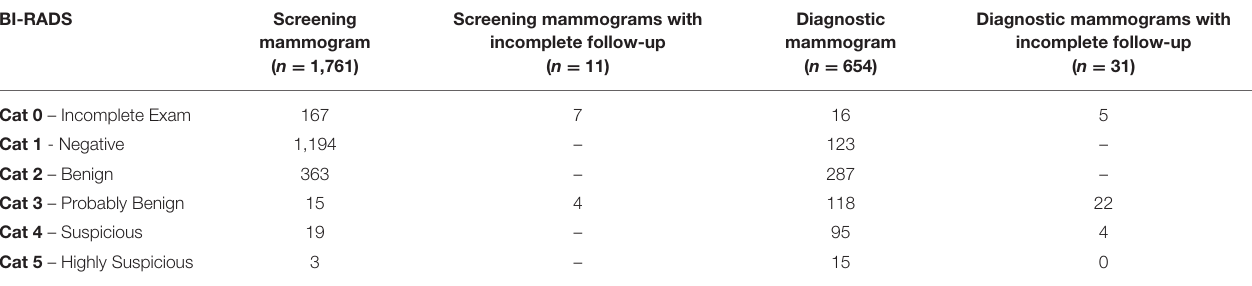
TABLE 3 | Mammography results by breast imaging reporting and data system (BI-RADS) category ( n -1,974 unique patients).